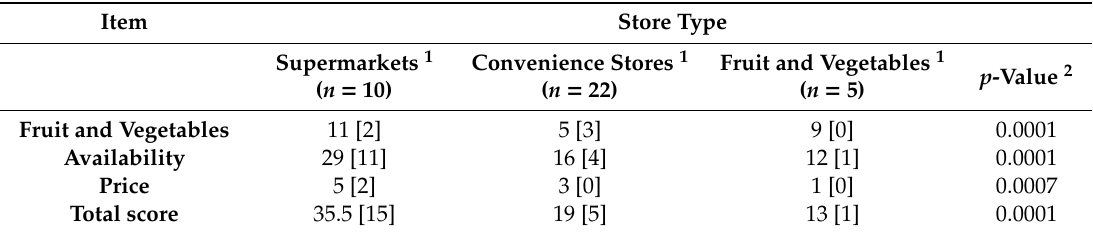
Nutrition Environment Measurement Survey in Stores for Mediterranean contexts (NEMS-S-MED) scores by store type.